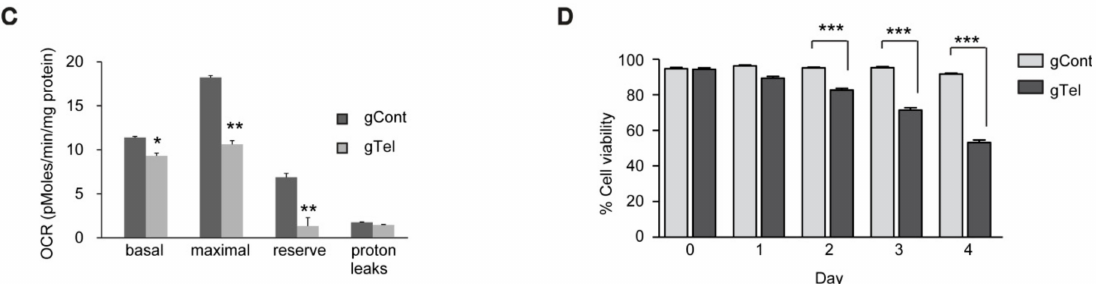
Figure 3. Mitochondrial dysfunction induced by CRISPR-Cas9 mediated telomere removal. ( A ) Quantification of red and green fluorescence intensities for each SH-SY5Y cell culture plate stained with JC-1 dye from the indicated experimental groups ( n = 7 wells per group); ( B ) Mitochondrial stress testing of SH-SY5Y cells transfected with gTel or gCont determined by Seahorse oxygen consumption rate measurements; ( C ) Telomere removal by CRISPR-Cas9 caused an approximate 18% decrease in basal respiration and a 42% decrease in maximal respiration. CRISPR-ca9 mediated telomere removal reduced mitochondrial reserve capacity by 81% ( n = 5 assays per group); ( D ) Cell viability assessment showing gradually increased cell toxicity after expression of telomere targeting CRISPR-Cas9 in SH-SY5Y cells determined by the Trypan blue exclusion assay at the indicated days following transient transfection ( n = 7). Quantified data are expressed as mean ± SEM. Statistical significance was determined by unpaired two-tailed Student’s t test or ANOVA test with Tukey post-hoc analysis, * p < 0.05, ** p < 0.01, and *** p <